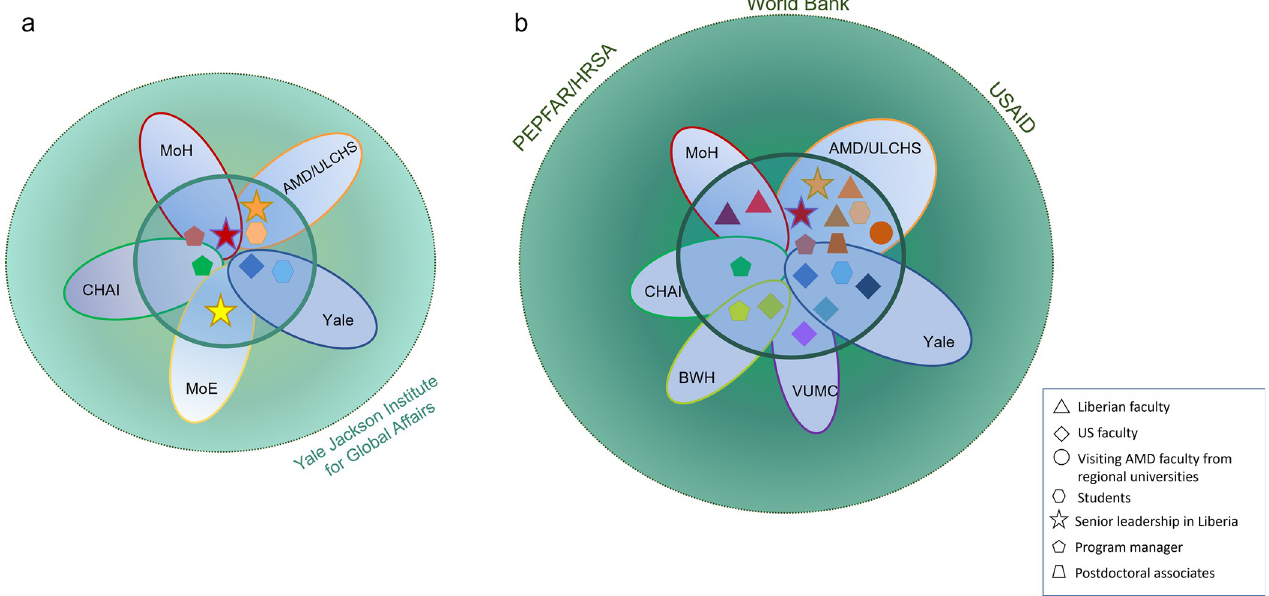
Fig 1. Formation of a community of inquiry through an international action-inquiry partnership. This figure depicts the individuals, institutions, and groups [26] involved in this community of inquiry after it first came together in 2015 at the direction of the Minister of Health of Liberia to support the country’s Health Workforce Program Strategy. a) In 2016, the President of Liberia asked the Ministers of Health (MoH) and Education (MoE) to improve conditions for medical students at Liberia’s only medical school, A.M. Dogliotti School of Medicine (AMD), which is part of the University of Liberia College of Health Sciences (ULCHS). The Ministers commissioned a mixed methods study from a Yale University (Yale) faculty member and her students, in collaboration with the Dean of AMD, and with facilitative partnership from program managers at the Clinton Health Access Initiative, Inc. (CHAI). The action and inquiry steps pursued by this team founded the community of inquiry, with funding from the Yale Jackson Institute for Global Affairs and, later PEPFAR/ HRSA. b) The community of inquiry expanded in subsequent years to include additional faculty and students at AMD, including visiting AMD faculty from west and east African medical schools, as well as faculty, staff, and program managers from Yale, Vanderbilt University Medical Center (VUMC), Brigham and Women’s Hospital (BWH), and Liberia’s Ministry of Health, with distinct (and sometimes intermittent) funding from a variety of sources (rendered complementary by the efforts of the community of inquiry) including the World Bank, USAID, and PEPFAR/HRSA.